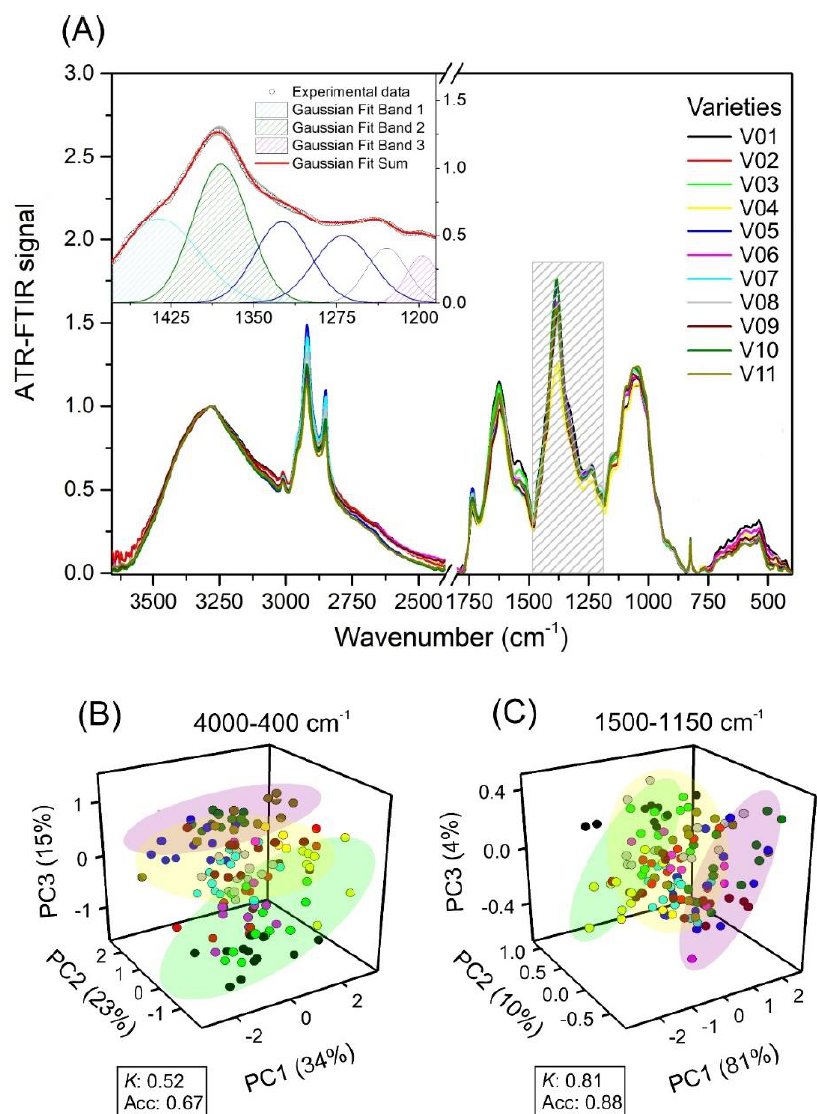
Figure 4. ( A ) Average ATR-FTIR signal profile of eleven varieties of lettuce over the full range (4000-400 cm −1 ) of ATR-FTIR spectroscopy and ranged from 1500 to 1150 cm −1 . The inset displays the experimental data and Gaussian fit curves (1436, 1380, and 1197 cm −1 ). ( B ) 3D plot of the principal component analysis score for the first three principal components (PC1, PC2, and PC3) of the spectroscopy data (4000-400 cm −1 ). ( C ) 3D plot of the principal component analysis score for the first three principal components (PC1, PC2, and PC3) of the spectroscopy data (1500-1150 cm −1 ). Data collected from lettuce plants. Green, yellow, and purple colors display correlation clusters of lettuce varieties that showed similar groups of pigments in leaves. K : Kappa and Acc: accuracy. The ATR-FTIR signal intensity was normalized at 3270 cm −1 (OH stretching band).